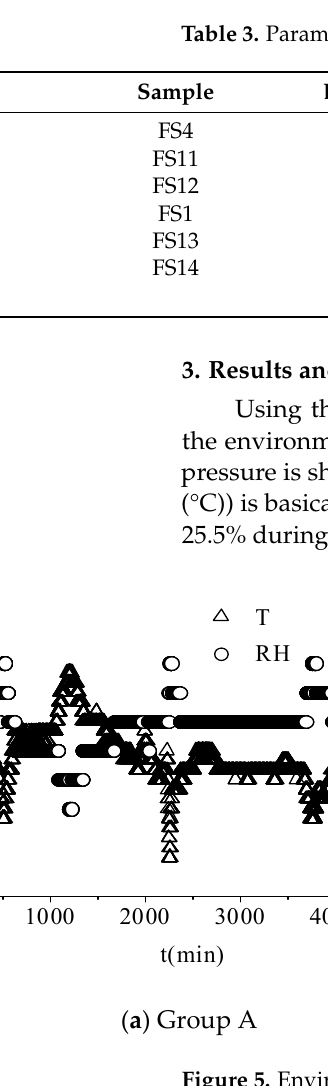
Figure 5. Environmental temperature and humidity during imbibition test without water pressure.